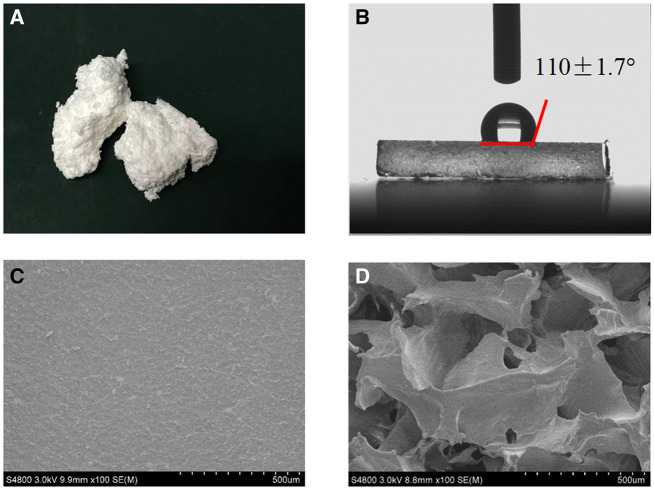
Digital images of B-PE appearance (A) and water droplet showing wettability (B). SEM images of B-PE film (C) and scaffold (D)